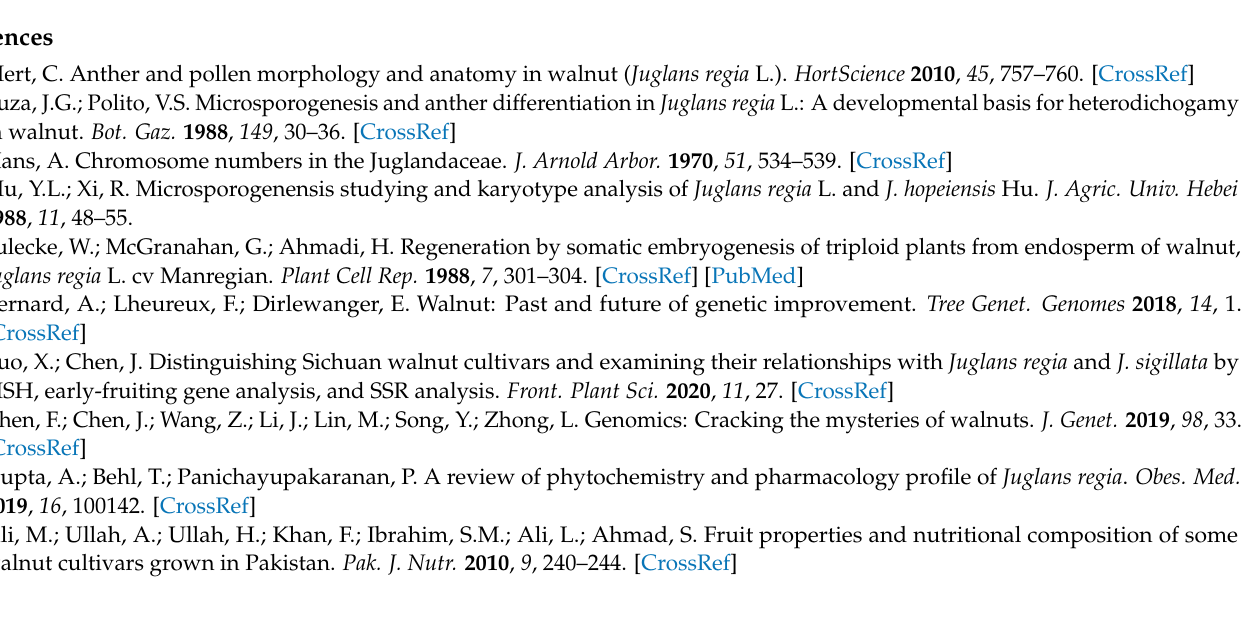
nut individuals. Table S2: Genetic diversity ( N A , H O , H E ), null alleles, null allele frequencies for 31 microsatellite loci. Table S3: Geographic distance matrix (in kilometers) for the 12 population of walnut. Table S4: Microsatellite data for the 12 populations across 31 loci. Figure S1: Correlation of geographic distance (in kilometers) and genetic distance (pairwise F ST ) among 12 populations of J. regia , including regression line ( r = 0.14, p = 0.22 at 1000 randomization). Figure S2: Spatial genetic diversity of 12 populations of Pakistan walnut: (a) Unbiased expected heterozygosity ( UH E ), (b) allelic richness ( A R ). Figure S3: Relationship between observed heterozygosity and elevation for 12 populations of walnut in